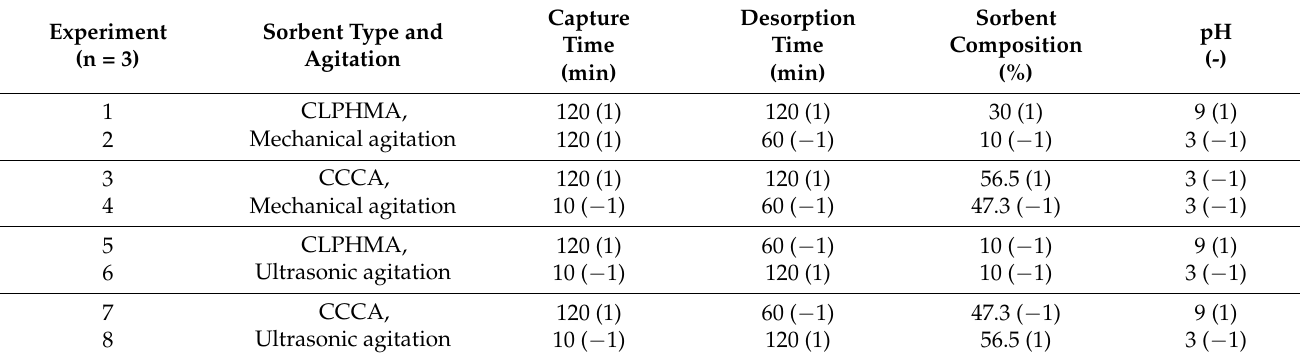
Table 7. Experiments to test the release of the compounds studied by the synthesized materials in urine samples. Numbers in parentheses correspond to the coded values of the variables under study. Experiment